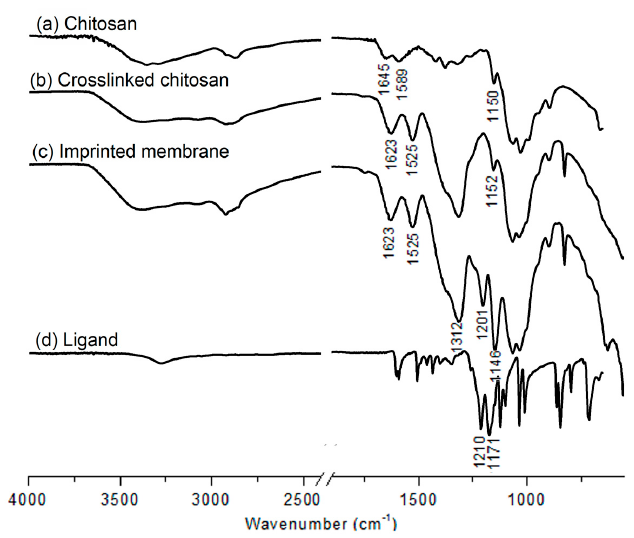
Figure 5. FTIR spectra of chitosan ( a ); Glutaraldehyde (GA) crosslinked chitosan ( b ); Pd-IAzoCsM ( c ); and PABSA ( d ).